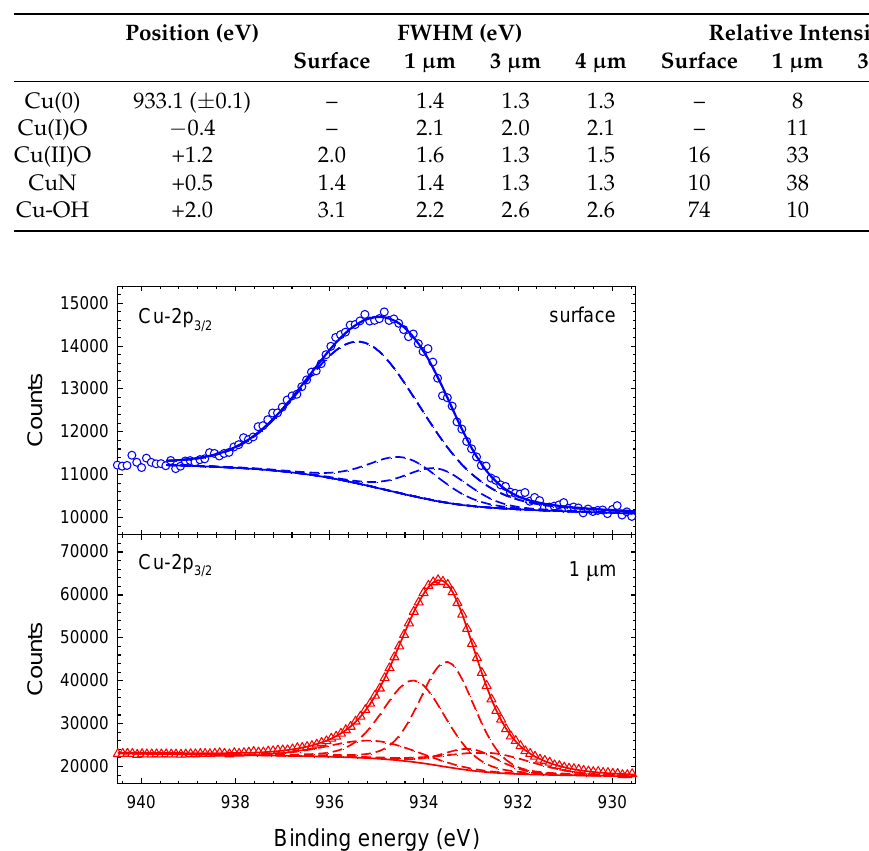
Table 1. Line positions relative to Cu(0) peak, FWHM (full-width-at-half-maximum), and relative